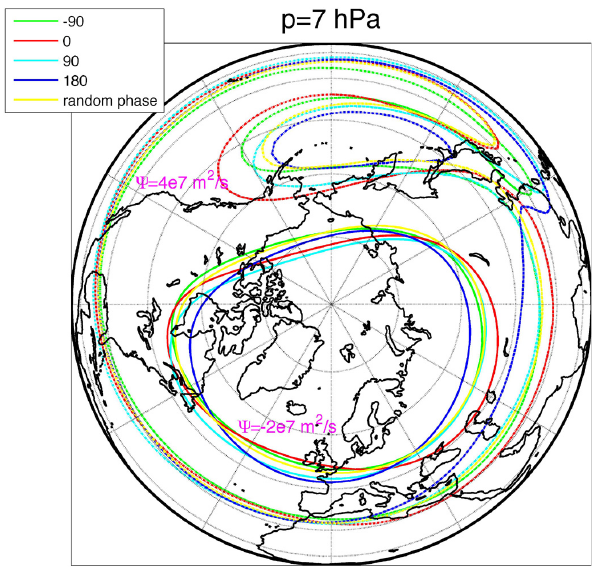
Fig. 7. Same as Fig. 6 but for the composites of the stream function for different phases of the 20-day oscillation above Aral Sea. Now the timing marks of maximal and minimal ozone above Aral Sea (60 ◦ E, 47.5 ◦ N) are taken. The legend is valid for both solid and dashed streamlines at 9 = − 2 × 10 7 m 2 s − 1 and 9 = 4 × 10 7 m 2 s − 1 ,